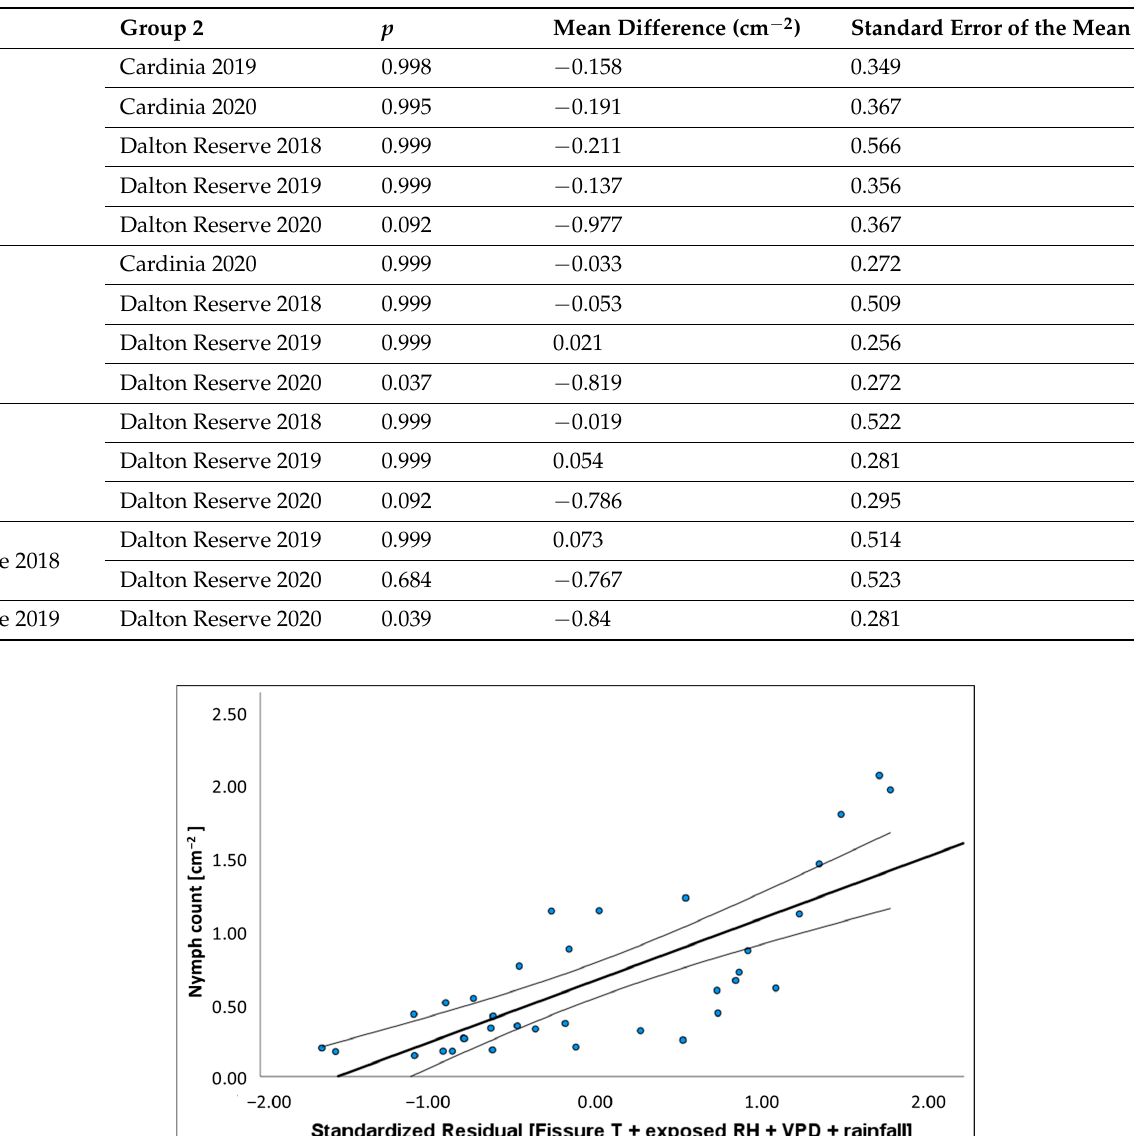
Figure A1. Scatterplot of Marchalina hellenica nymph density (cm − 2 ) plotted over standardised residual of best climate predictor variables. Regression model is plotted as continuous black line, and curved black lines indicate 95% confidence intervals of the mean. Climate variables were selected if they provided the strongest model identified for a given climate variable. Summary: p < 0.001, F 1,33 = 44.439, r 2 = 0.574; model equation: Y = 0.427 x + 0.656.